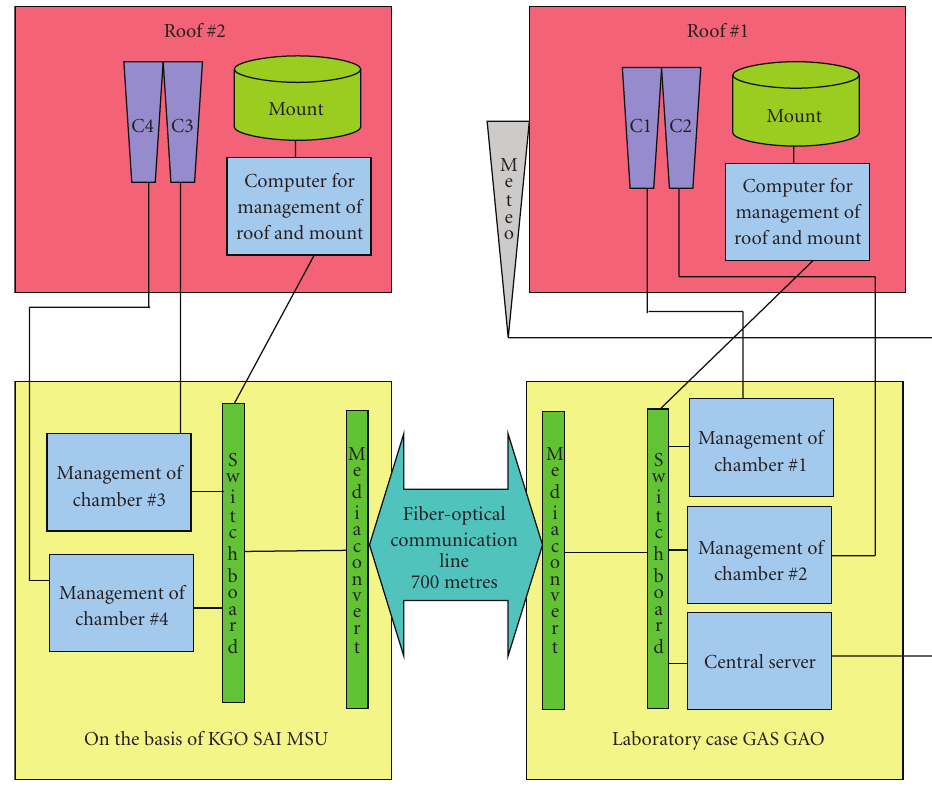
Figure 3: Schematic diagram of the layout of the equipment in the MASTER-VWF4 experiment.